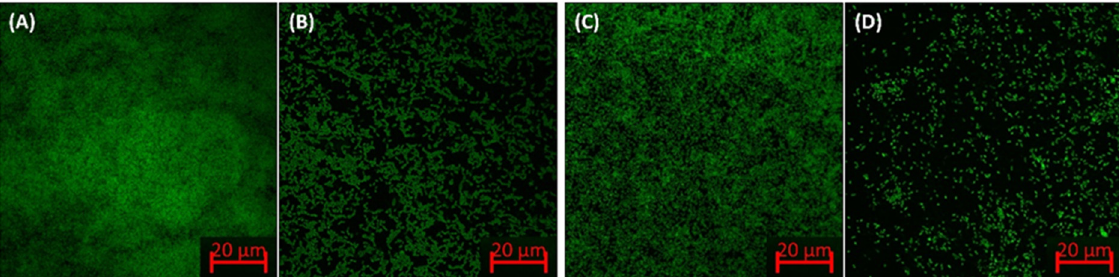
Figure 5. Confocal microscopic images of the E. coli and P. aeruginosa biofilms in the absence and presence of ZnO-NPs. ( A ) Untreated control E. coli ; ( B ) E. coli treated with ½ × MIC of ZnO-NPs; ( C ) untreated control P. aeruginosa ; ( D ) P. aeruginosa treated with ½ × MIC of ZnO-NPs.